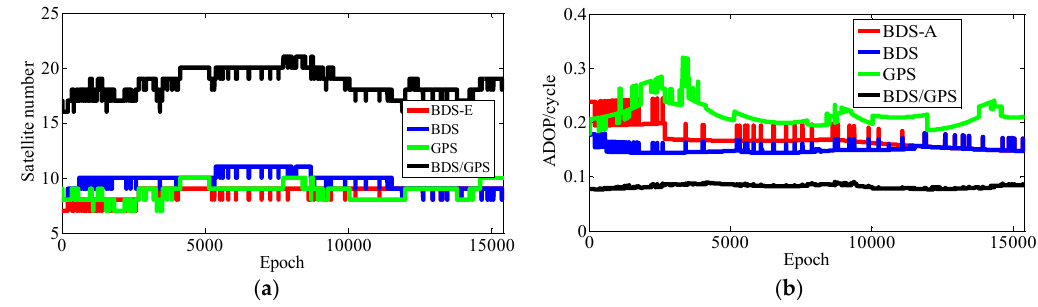
Figure 23. Satellite number and ADOP of four systems. ( a ) The satellite number of four systems. ( b ) The ADOP of four systems.